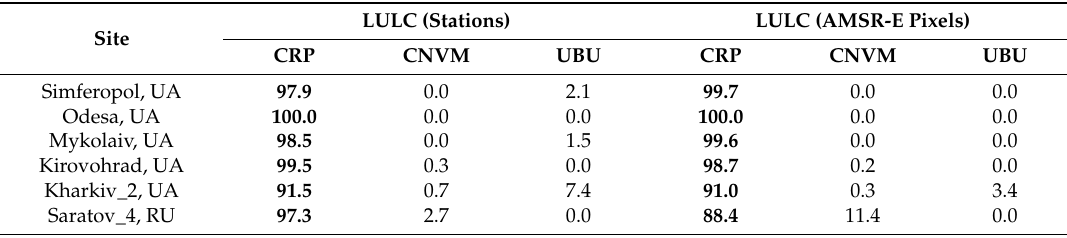
Table 4. Average (2003–2010) MODIS land cover with the 10 km buffer zone for meteorological stations and corresponding AMSR-E pixel study sites. Bold indicates the dominant land cover (all sites are in crop dominated